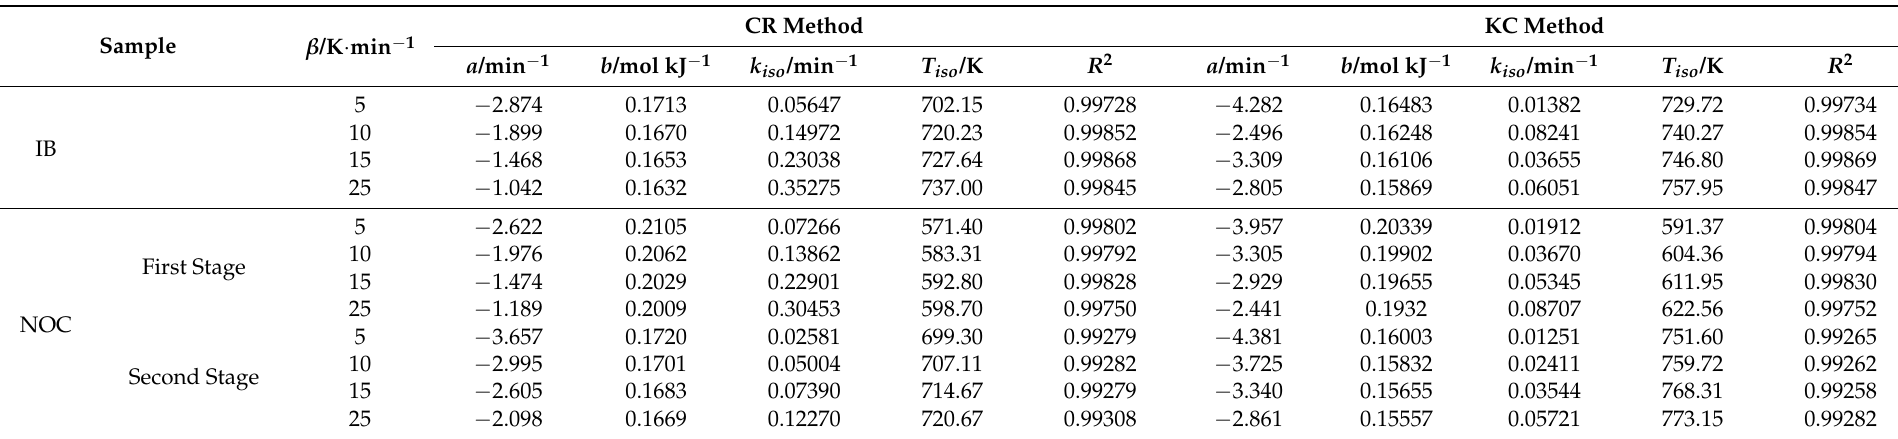
Table 5. Artificial isokinetic parameters obtained by using the KCE for IB and NOC pyrolysis at different heating